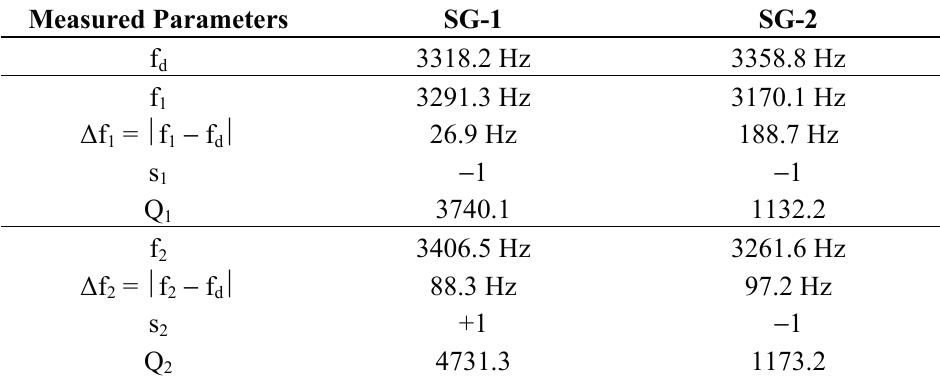
Table 3. Measured parameters of the two tuning fork micro-gyroscope prototypes.